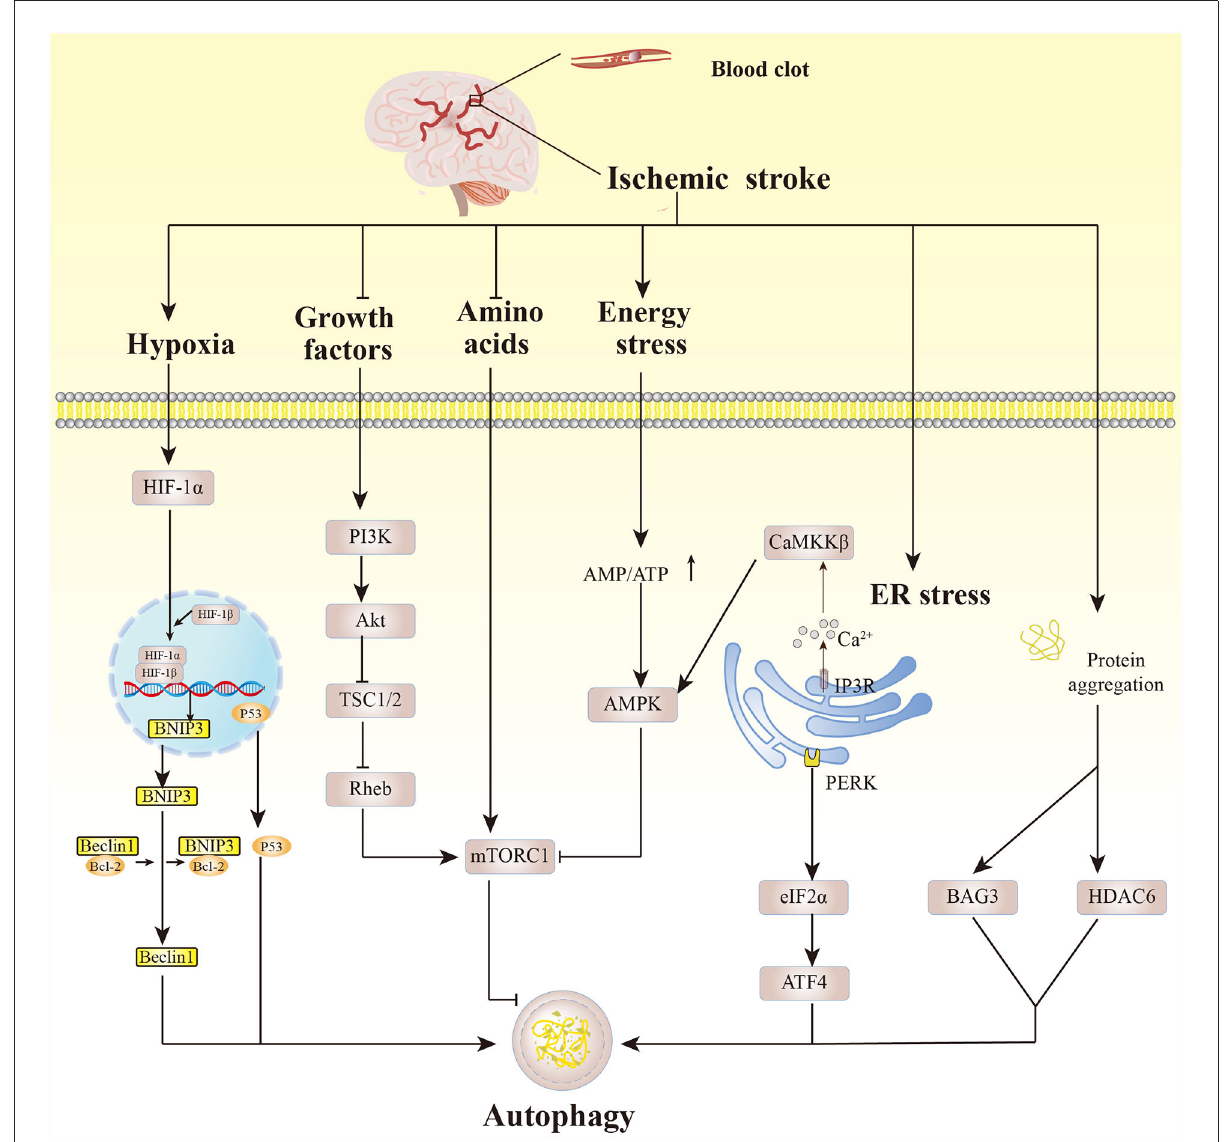
FIGURE2 Autophagy pathways affected by pathological changes after cerebral ischemia. Hypoxic conditions activate HIF-1 α which then binds to HIF-1 β , and BNIP3 dissociates Beclin1 from the Beclin1/Bcl-2 complex, eliciting autophagy. p53 also induces autophagy. Growth factors that are deficient after cerebral ischemia activate PI3K, inducing Akt phosphorylation, then inhibit TSC1/2 and Rheb, activating mTORC1. Amino acid deficiency under cerebral ischemia induces autophagy by inhibiting mTORC1 activity. Similarly, energy exhaustion leads to increased AMP/ATP, and activation of AMPK inhibits the activity of mTORC1, mediating autophagy. Cerebral ischemia can trigger the release of Ca2 + from the inositol 1,4,5-triphosphate receptor on the ER, activating CaMKK β , thereby activating AMPK. ER stress mediates autophagy mainly through the PERK-eIF2 α -ATF4 pathway. Excessive misfolded proteins caused by ischemic injury promote autophagy by upregulating Bcl2-associated athanogene 3 and histone deacetylase